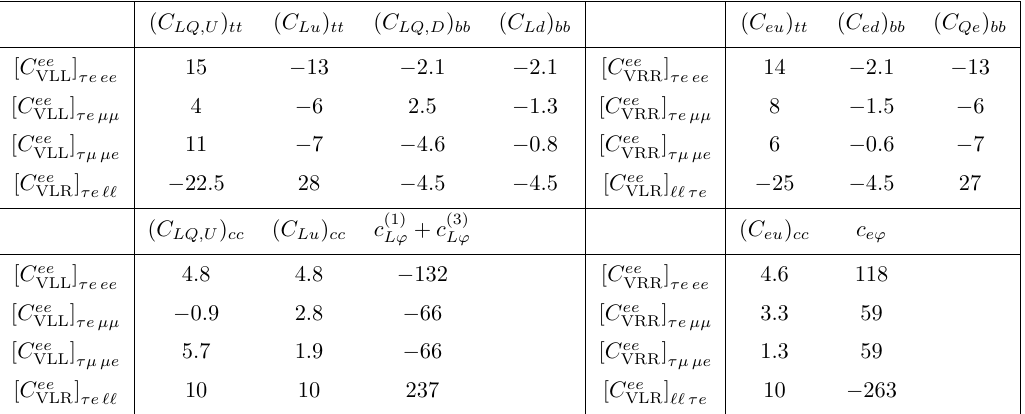
Table 24 . The Wilson coefficients of purely leptonic operators (in units of 10 − 3 ) at µ = 2 GeV induced by nonzero top-, bottom- and charm-quark vector-like operators at the scale Λ = 1 TeV, and by Z CLFV vector and axial couplings. Note that [ C ee also generated with the same contributions as the operators listed